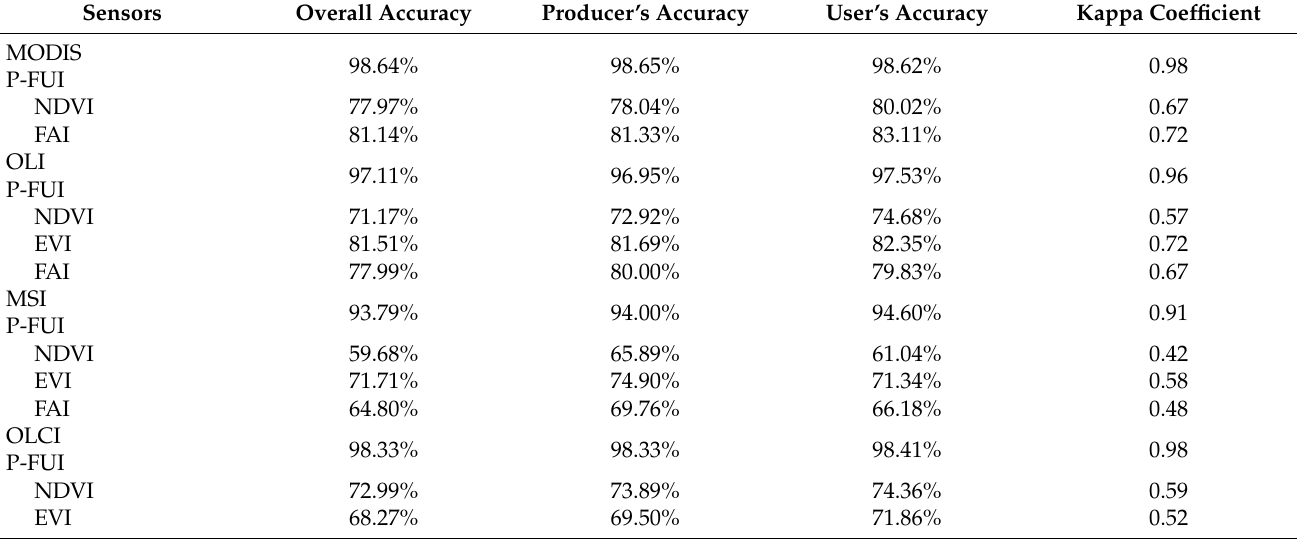
Table 4. Quantitative evaluation of the CBs identification accuracy based on MODIS, OLI, MSI, and OLCI sensors.